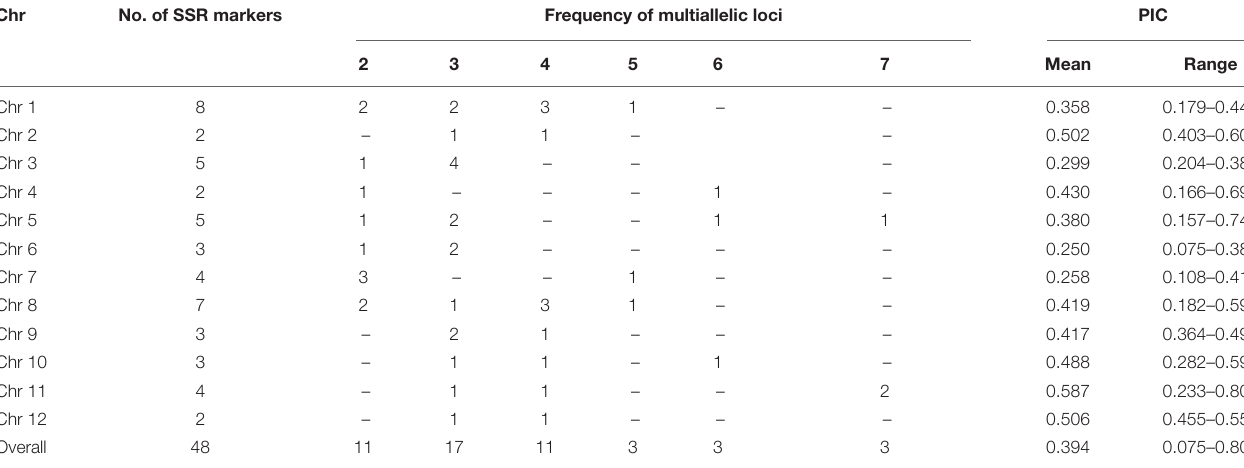
TABLE 4 | Marker polymorphism and allelic status of GCP panel microsatellite markers among aromatic rice germplasm from Manipur. Chr No. of SSR markers Frequency of multiallelic